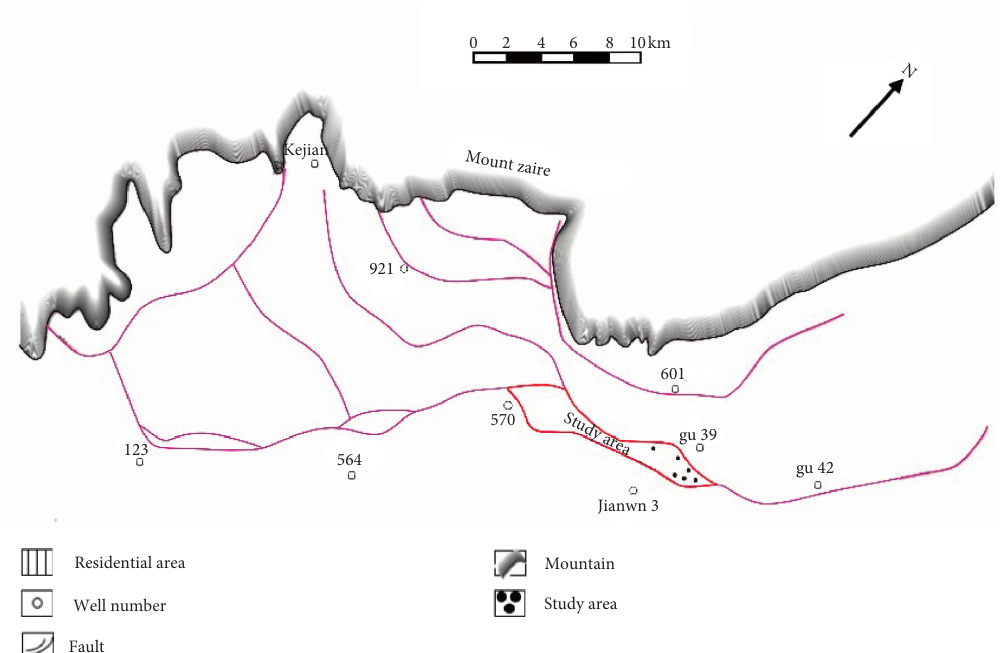
Figure 1: Location map of the study